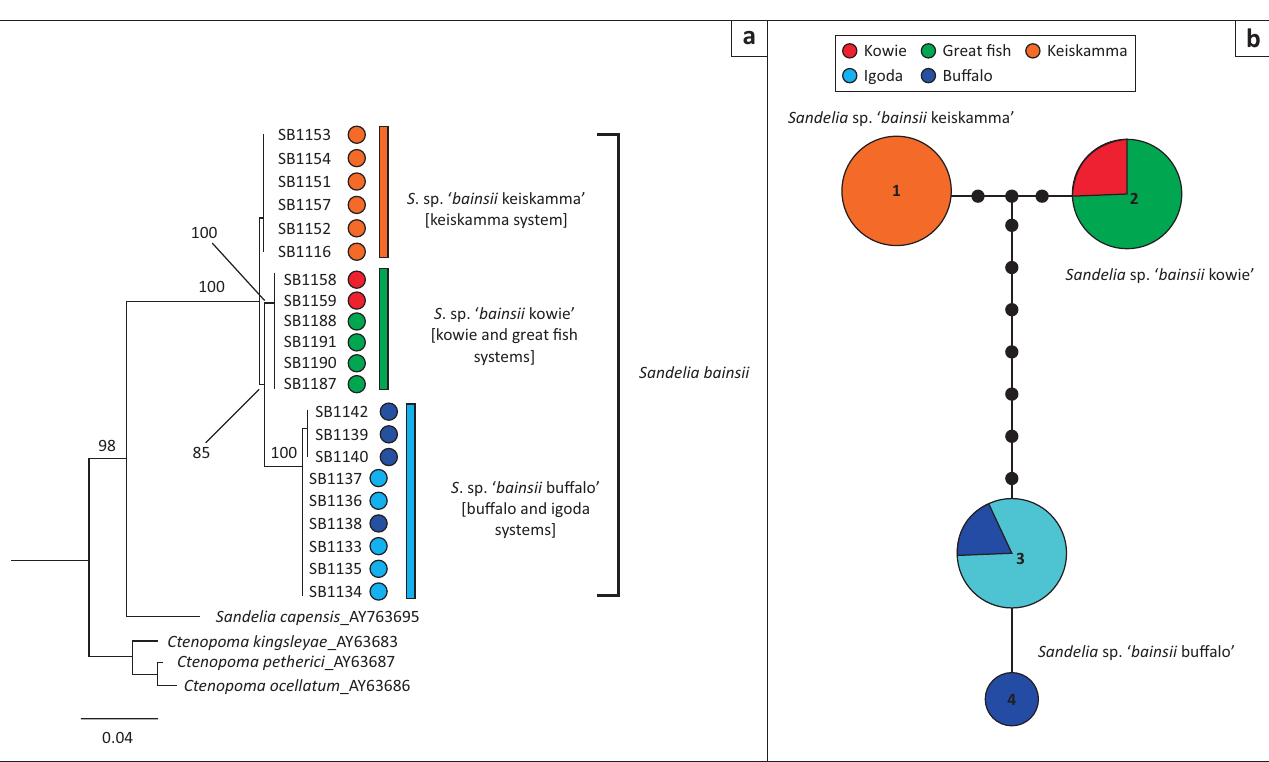
FIGURE 2: Maximum likelihood phylogeny (a) and TCS haplotype network (b) showing the existence of three lineages ( Sandelia sp. ‘ bainsii Kowie’, Sandelia sp. ‘ bainsii Keiskamma’ and Sandelia sp. ‘ bainsii Buffalo’) within the Eastern Cape rocky, Sandelia bainsii . The river systems where each of these lineages were recorded are indicated. TABLE 2: Mitochondrial 16S ribosomal ribonucleic acid sequence divergence estimates ( % ) among the three lineages identified within the Eastern Cape rocky, Sandelia sp. ‘ bainsii Kowie’, Sandelia sp. ‘ bainsii Keiskamma’ and Sandelia sp. ‘ bainsii Buffalo’